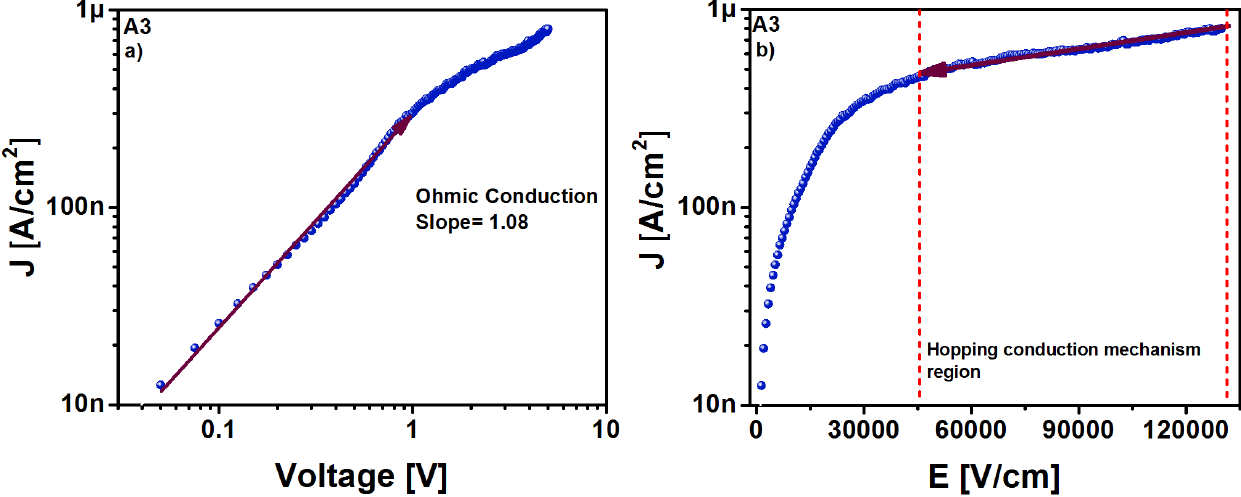
Figure 10. The current density in which ( a ) ohmic and ( b ) hopping conduction were present for the Au/SRO/Si structure having the unannealed SRO A3 film.